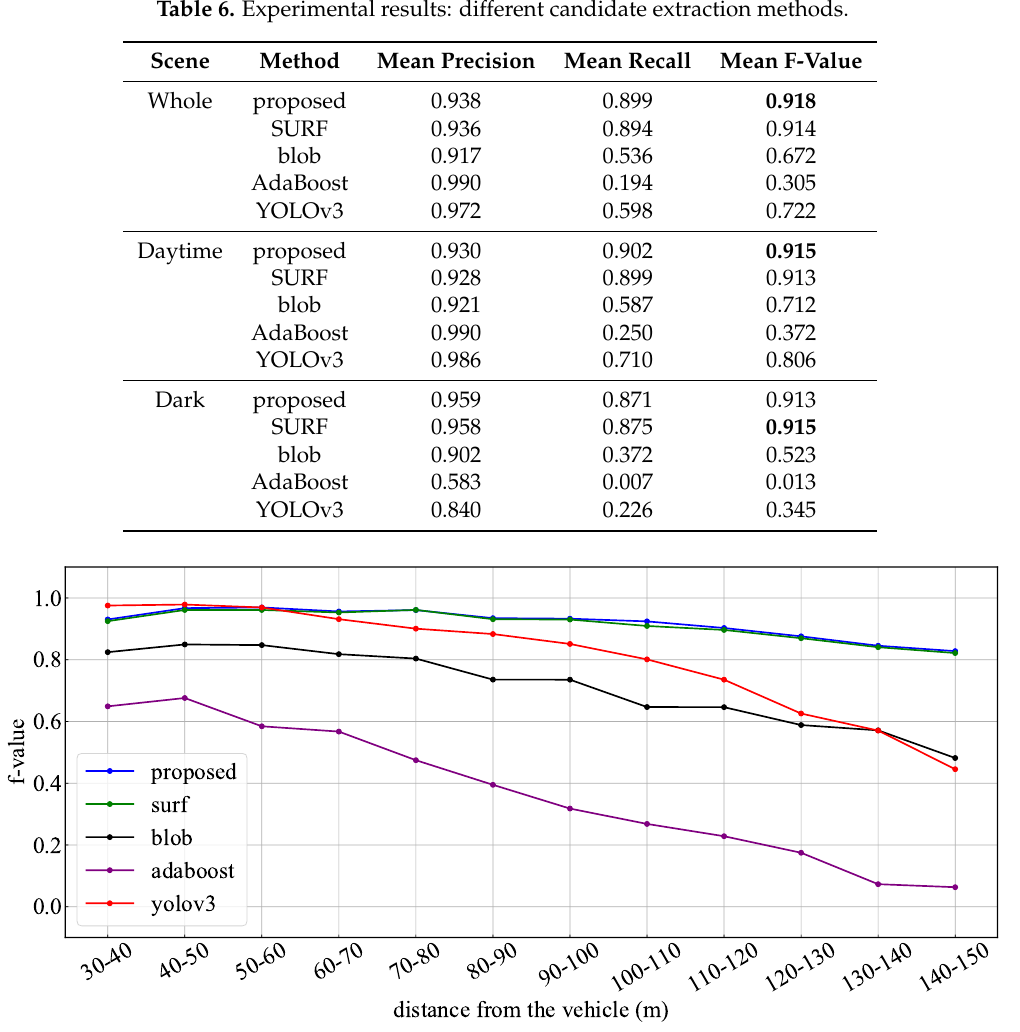
Figure 16. F values for daytime data: different candidate extraction